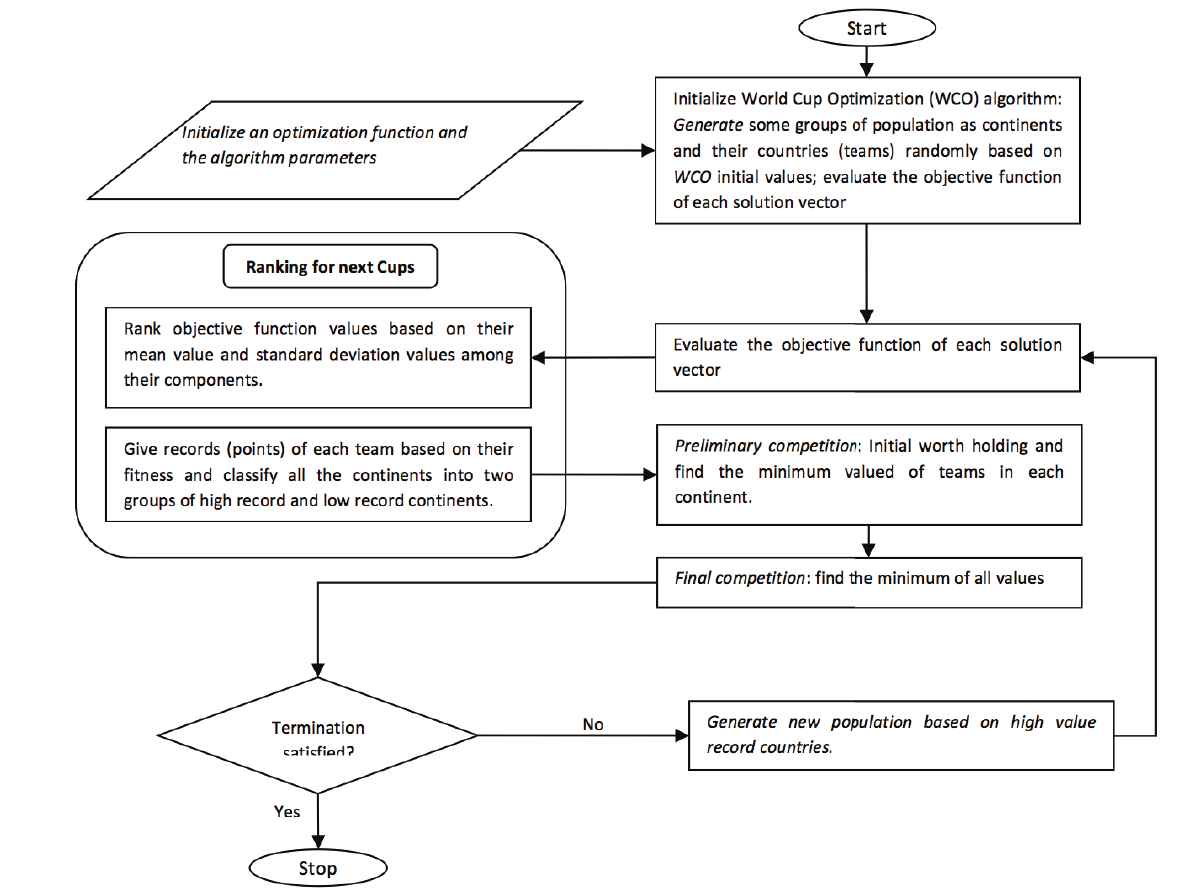
Figure 3: Flowchart of world cup optimization